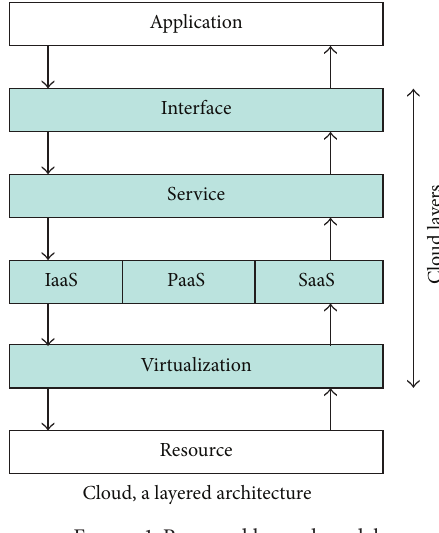
Figure 1: Proposed layered model.